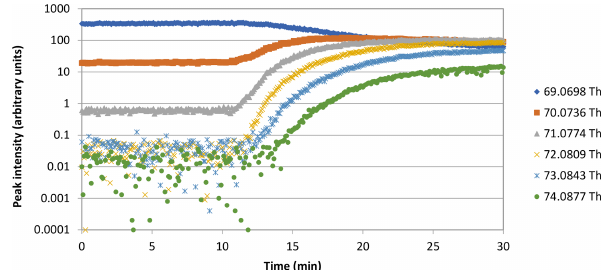
Figure 3. Labelling of isoprene emitted by red oak leaves upon 13 CO 2 -feeding in the air. Fully labelled plied to the plants starting from time T =